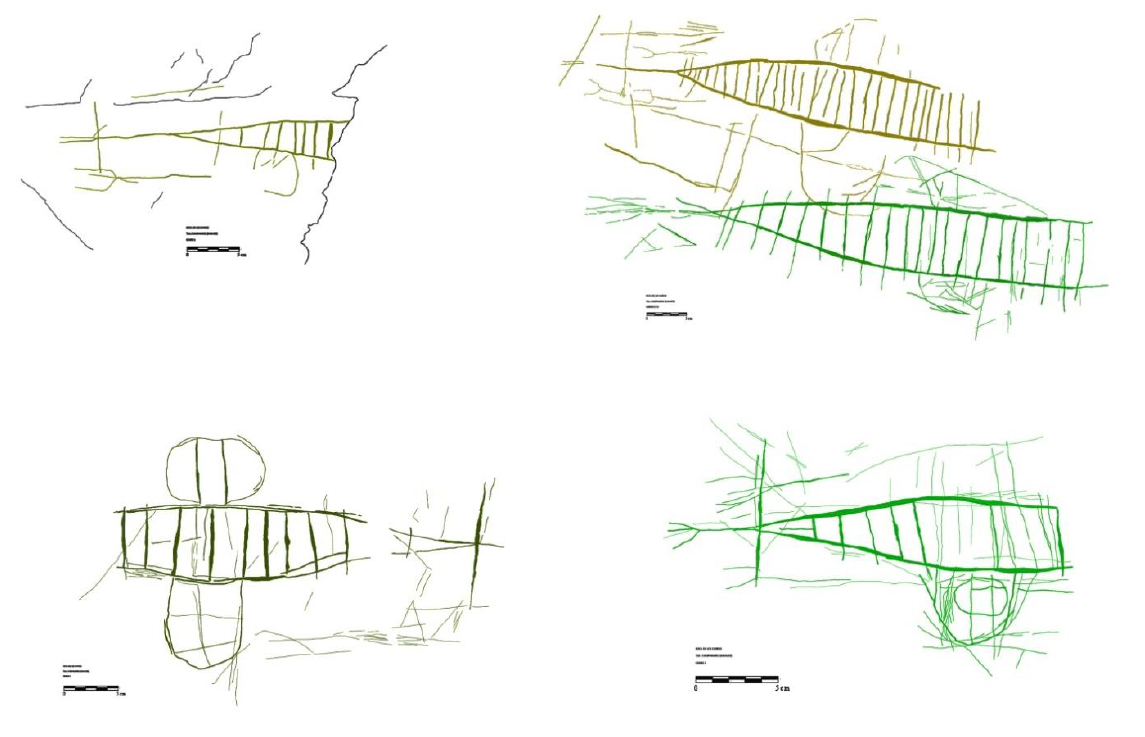
Figure 4. “Chariot” depictions in La Roca de los Carros (Campanario). “Chariot” 1 ( upper left ); “chariots” 2 and 3 ( upper right );” Chariot” 4 ( lower left ); “Chariot” 5 ( lower right